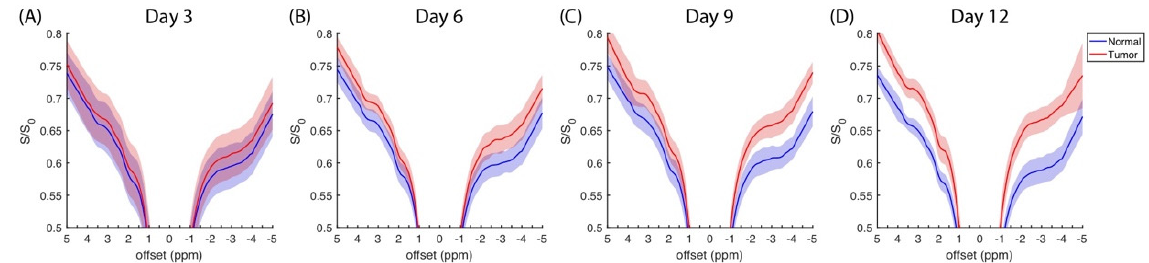
Figure 1. Average z ‐ spectra (N = 9) from normal (blue) and tumorous (red) brain as measured on days 3 ( A ), 6 ( B ), 9 ( C ), and 12 ( D ). Shading areas indicate standard deviation resulting from animal variation. Saturation amplitude and saturation duration are 0.9 μ T and 4 s, respectively.